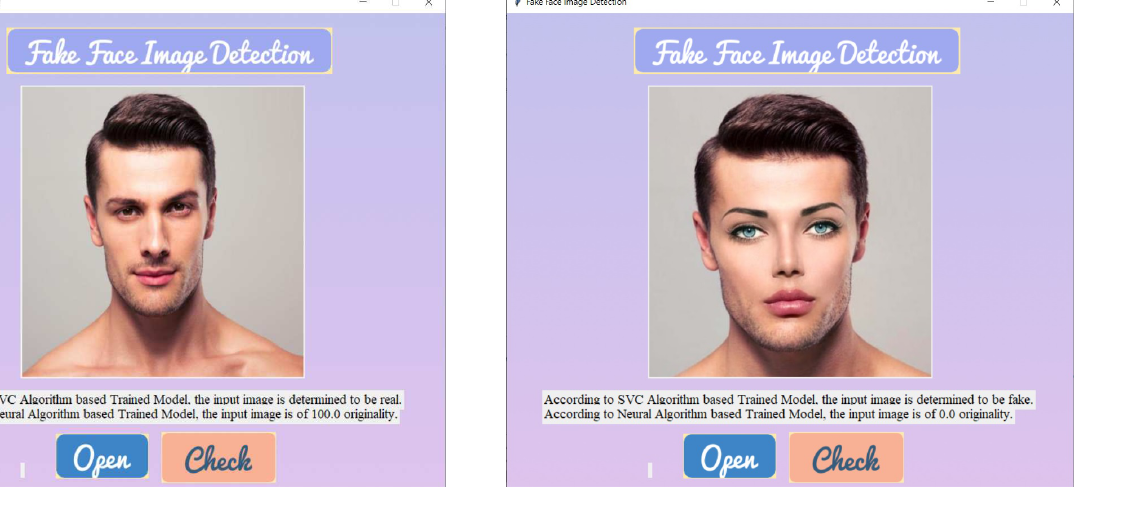
Figure 8. Result of a real image